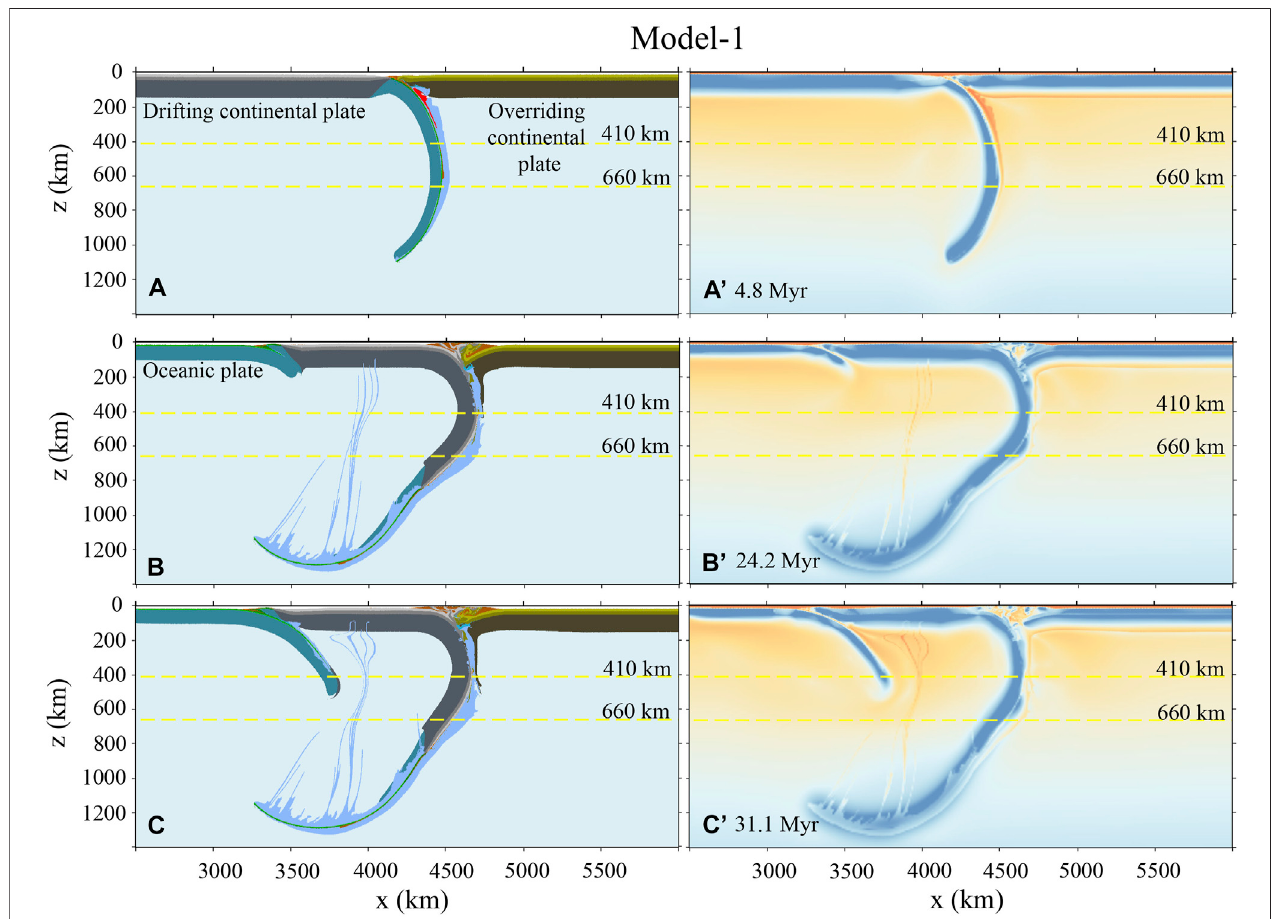
FIGURE 3 | Model-1 evolution with a strong overriding plate. The reconstruction-based convergence rate is applied from 55 Ma ( Figure 2C ). The plastic friction coef fi cientoftheoverridinglithosphericmantle isinitially λ · sin ( φ ) (cid:2) 0.6andwilldecrease linearlyto0.1withtheaccumulatedplasticstrainto ε plas =1( Supplementary Table S2 and Supplementary Equation S11 in the supporting information), which is the same as that of the underthrusting Indian lithospheric mantle. (A – C) The composition fi eld evolution with the corresponding colorbar is shown in Figure 2A . (A ’ – C ’ ) The effective viscosity evolution with the corresponding colorbar is shown in Figure 2B